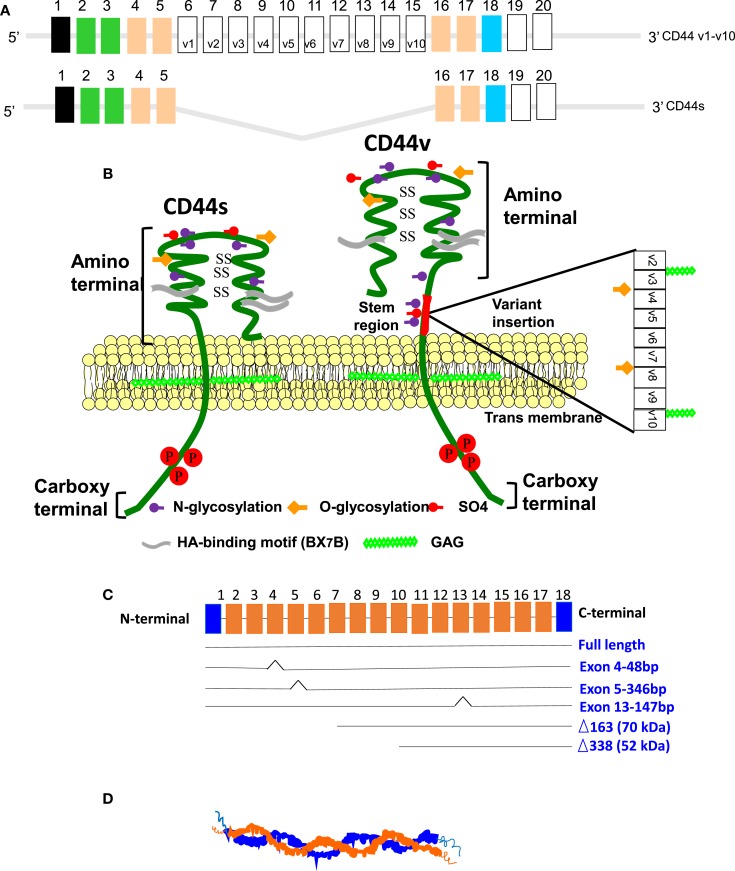
(A) Mouse CD44 and RHAMM gene/protein structures in mice. Model structure of alternative splicing in CD44. CD44 pre-mRNA is encoded by 20 exons in mouse and 19 exons in human being. The common standard CD44s (hematopoietic) form contains no extra exons, and the protein has a serine motif encoded in exon 5 that can initiate synthesis of a chondroitin sulfate or dermatan sulfate chain. Alternative splicing of CD44 predominantly involves variable insertion of 10 extra exons with combinations of exons 6–15 and spliced in v1–v10 into the stem region, of which v3 encodes a substitution site for a heparan sulfate chain. Variable numbers of the v exons can be spliced in epithelial cells, endothelial cells, and inflammatory monocytes and also are upregulated commonly on neoplastic transformation depending on the tissue. (B) Model structure of alternatively spliced CD44 proteins. The CD44 protein is composed of an extracellular N-terminal domain, a stem region in the extracellular domain close to the transmembrane region, where the variant exon products (red/violet circles) are inserted, the transmembrane region, and the carboxyl terminal cytoplasmic tail. There are multiple sites for N-glycosylation (purple circles) and O-glycosylation (orange circles), and a sulfation domain. The N-terminal portion contains highly conserved disulfide bonds as well as 2 BX7B motifs, both of which are essential for HA binding. CD44 is subjected to extensive glycosylation, sulfation, and attachment of GAGs that contribute to regulation of the HA-binding activity. The C-terminal cytoplasmic tail contains several phosphorylation sites that regulate the interaction of CD44 with the cytoskeletal linker proteins, as well as with SRC kinases. (C) RHAMM exon structure. The full-length protein (85 kDa in human beings) is largely associated with microtubule formation during the cell cycle progression. Three isoforms are generated by alternative splicing of exon 4, 5, or 13. Loss of exon 4 disrupts association with microtubules and results in the appearance of RHAMM in the cell nucleus. N-terminal truncations that may be generated by a posttranslational mechanism are constitutively present in some aggressive breast cancer cell lines and tumors. These accumulate in the nucleus and on the cell surface. (D) The secondary structure of RHAMM. RHAMM can self-associate to form random coiled coils (132).